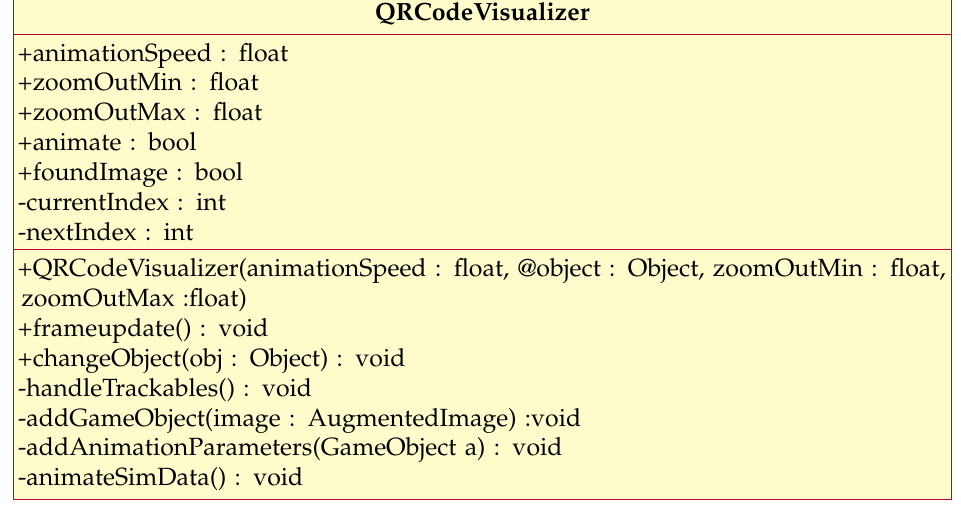
Figure 5. Class diagram of the QRCodeVisualizer with an overview of the essential functions and